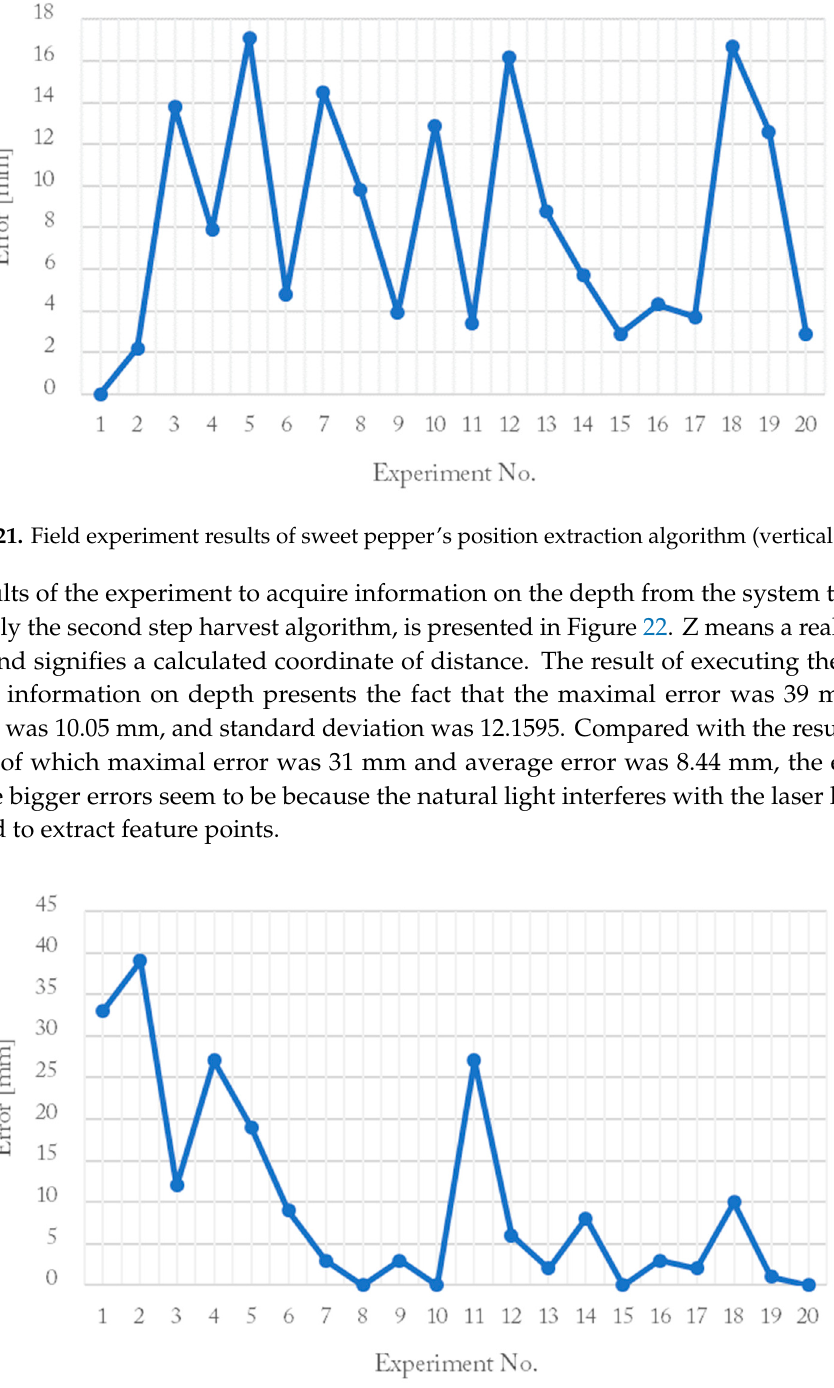
Figure 22. Field experiment results of distance compute algorithm.